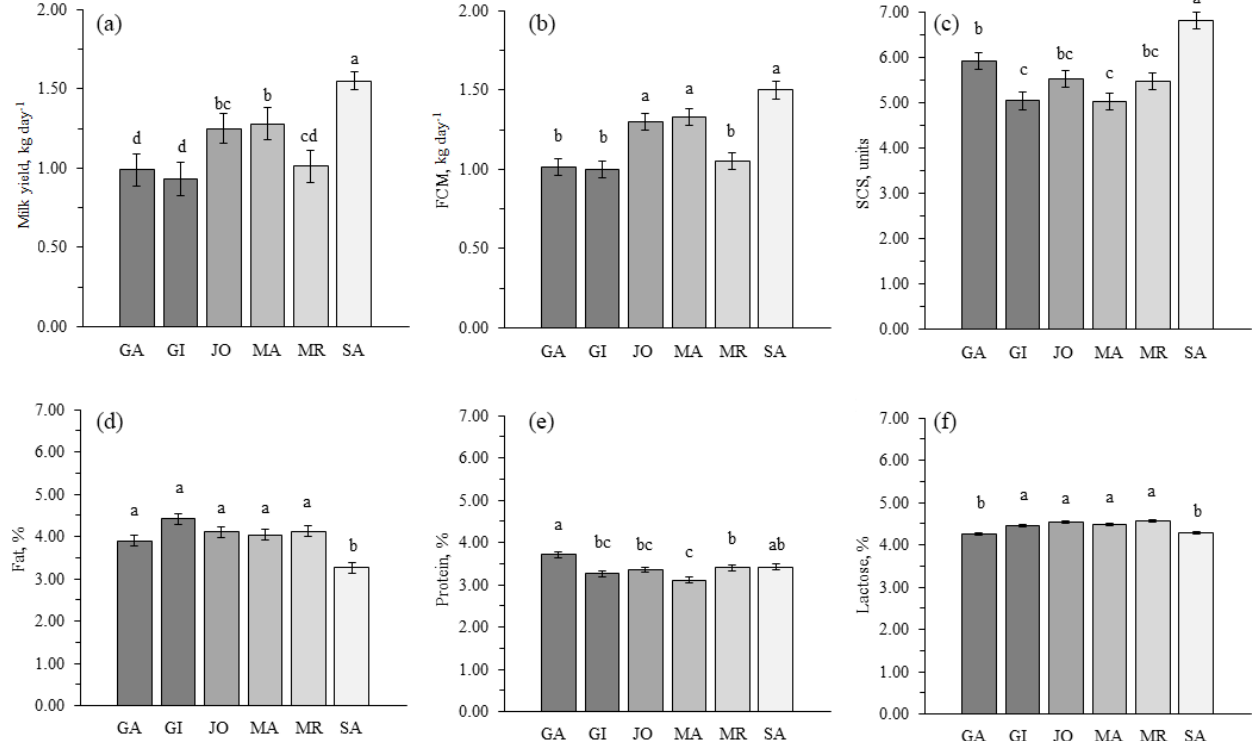
Figure 1. Least squares means (with SE) for (a) milk yield, (b) fat-corrected milk at 3.5% (FCM), (c) somatic cell score (SCS), (d) fat per- centage, (e) protein percentage, and (f) lactose percentage for Garganica (GA), Girgentana (GI), Jonica (JO), Maltese (MA), Mediterranean Red (MR) and Saanen (SA) goat breeds. Means with different letters within a trait are significantly different ( p< 0 .